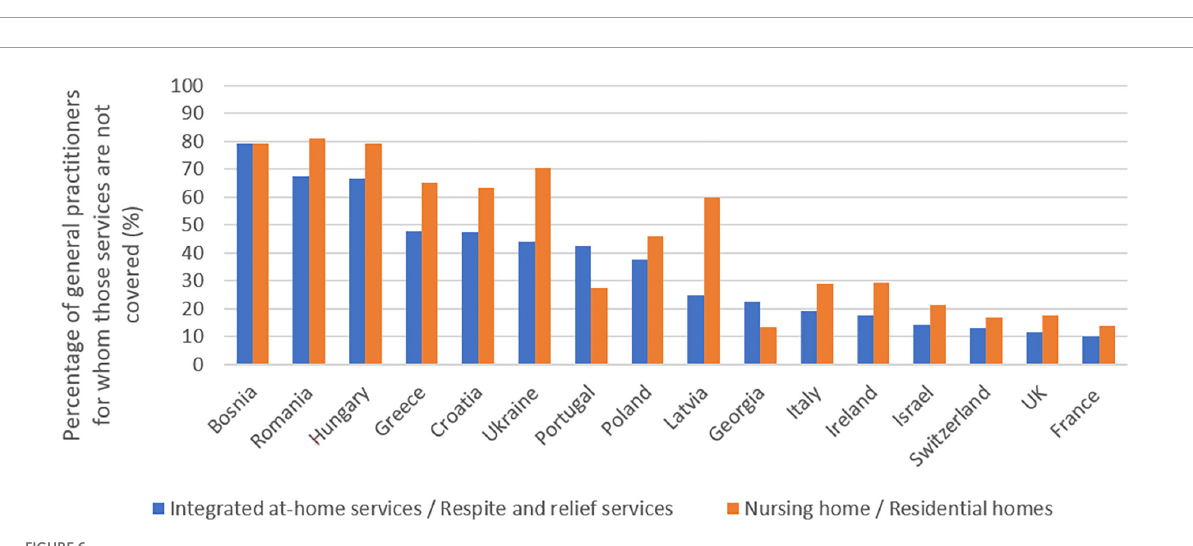
FIGURE6 Intermediate care services: subsidization by the healthcare